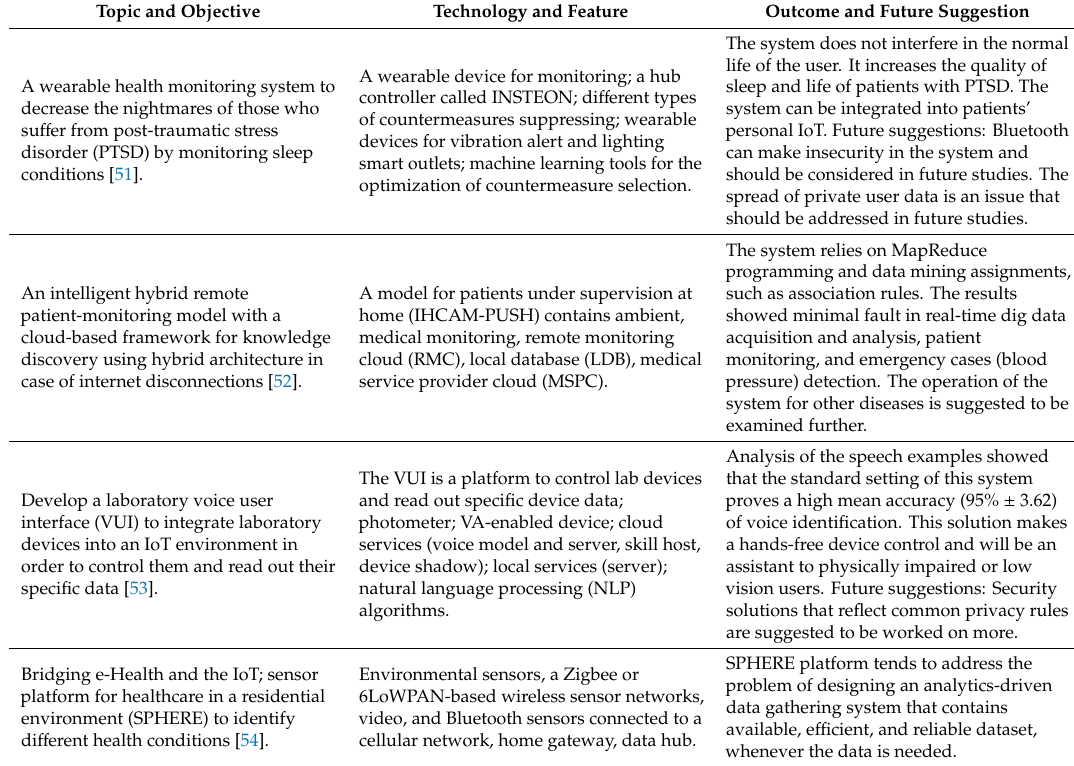
Table 6. Summary of selected papers focusing on the care system